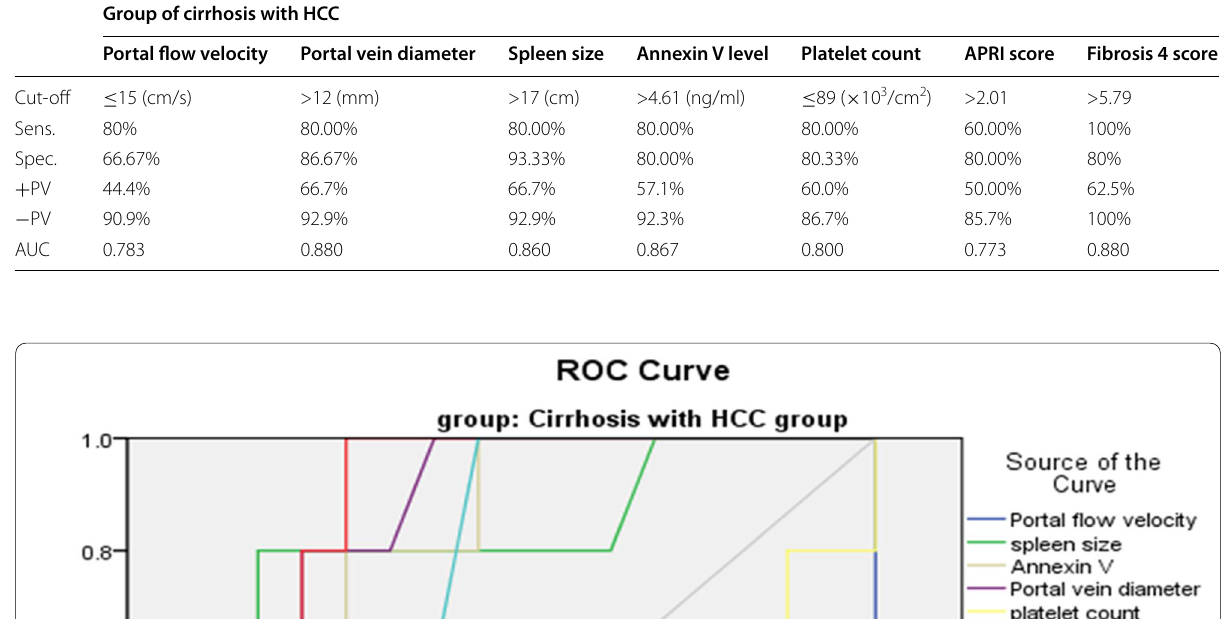
Table 3 Validity of portal flow velocity, portal vein diameter, spleen size, platelet count, Annexin V level, APRI score, and Fibrosis 4 score as PVT markers in cirrhotic with HCC patients